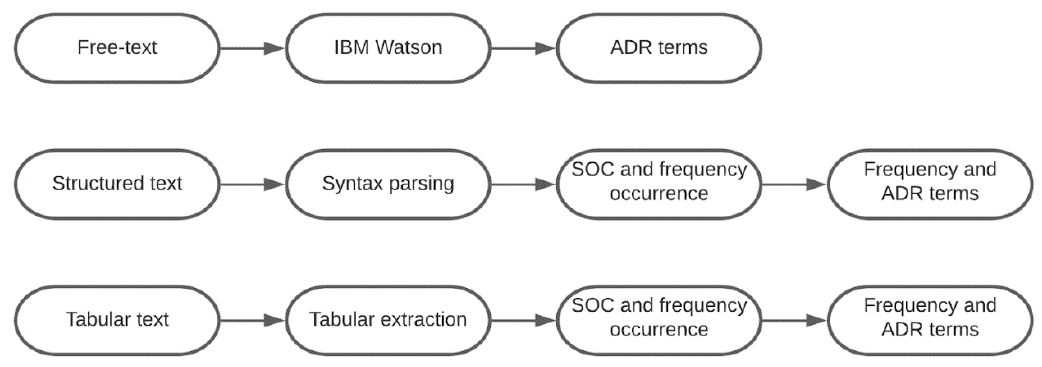
Figure 5. An Overview of the ADR Extraction Pipeline.